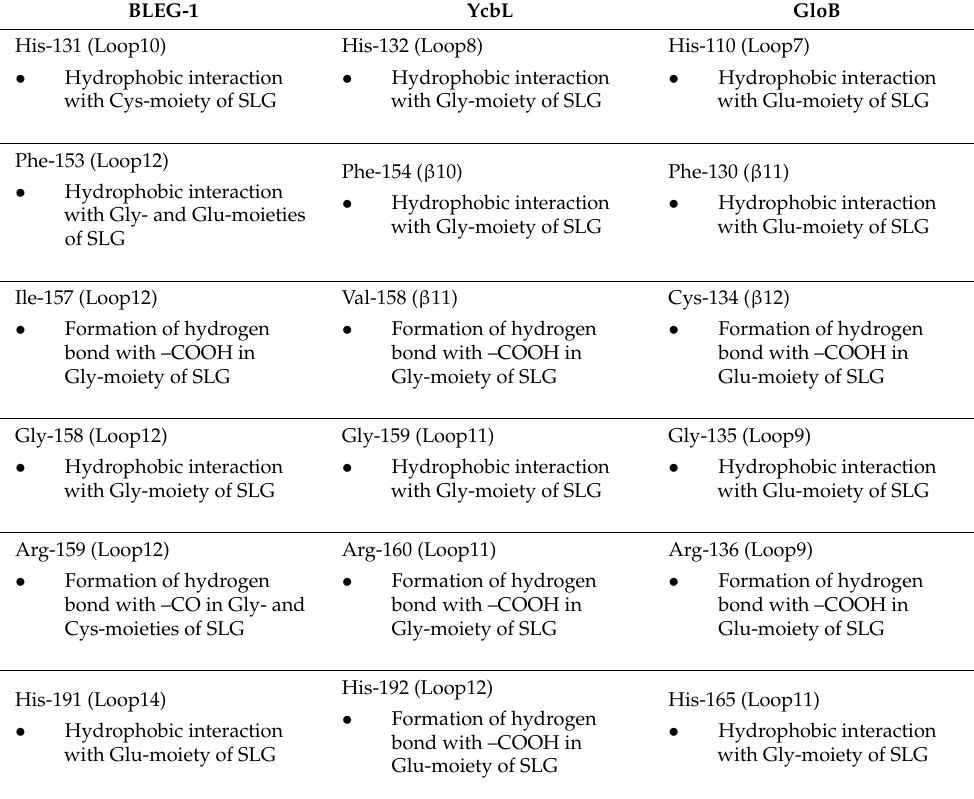
Table 4. Structurally aligned SLG binding residues in BLEG-1, YcbL, and